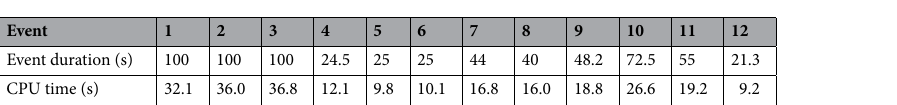
Table 3. CPU time requested for solving the transient analyses for each seismic record of Table